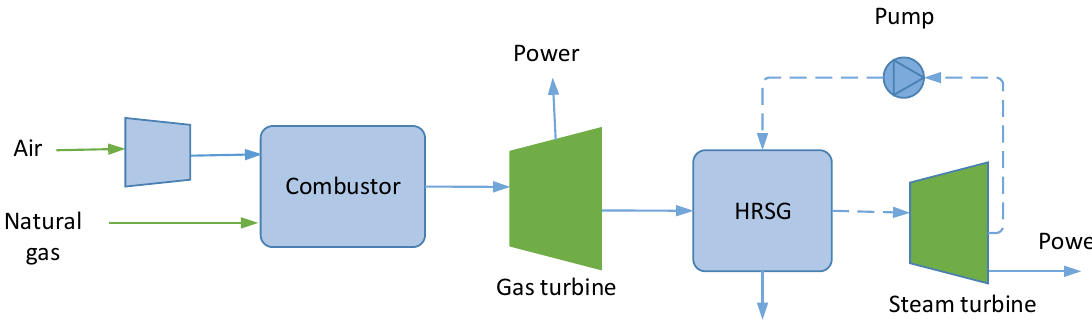
Figure 3. Flow diagram of combined